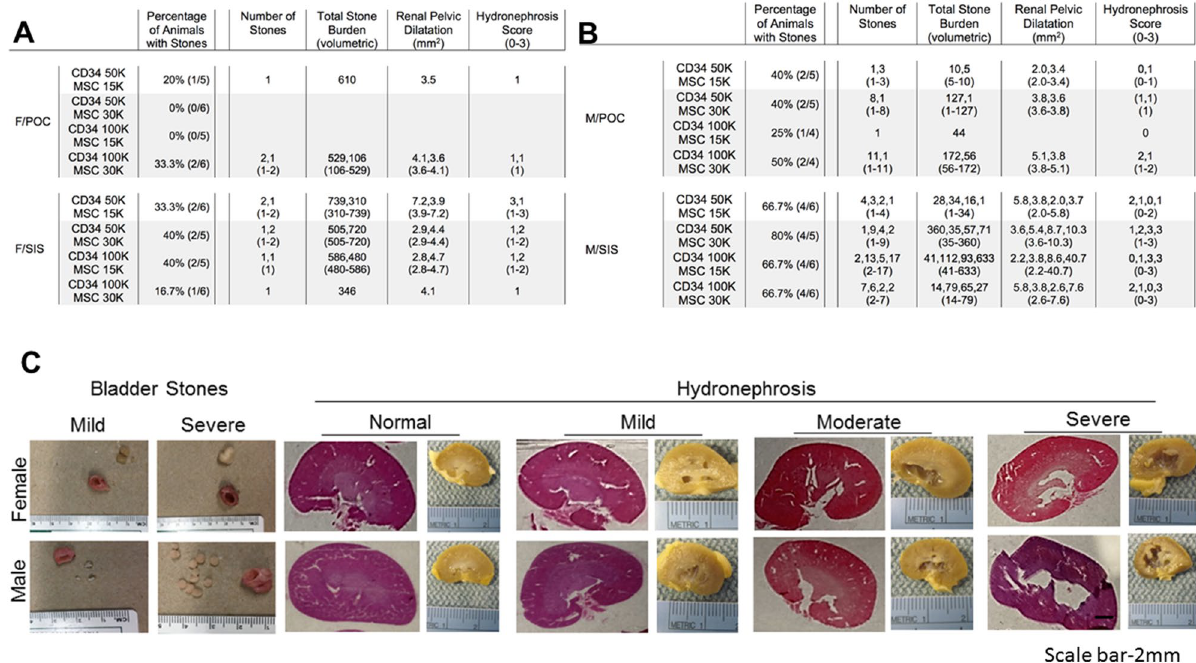
Figure 2. Characterization of the condition of 10-week post-augmentation rat bladders and kidneys. ( A , B ) Tables show percentage of rats with bladder stones, number of stones, total stone burden (volumetric), renal pelvic dilatation (mm 2 ) and a hydronephrosis score resulting from varying ratios in the cell concentration of MSC and CD34 + HSPCs seeded on POC/SIS scaffolds (n = 4–6 before subsets). Female groups displayed a lesser percentage of stone positive animals and range in number of stones (22.7% and 1–2 stones) when compared to male groups (56.1% and 1–17). On average, male rats produced a greater number of smaller sized stones than female rats. ( C ) Images and H&E stains demonstrate the range in severity of bladder stone formation and hydronephrosis, between female and male augmented rats (1x). Scale bar: 2